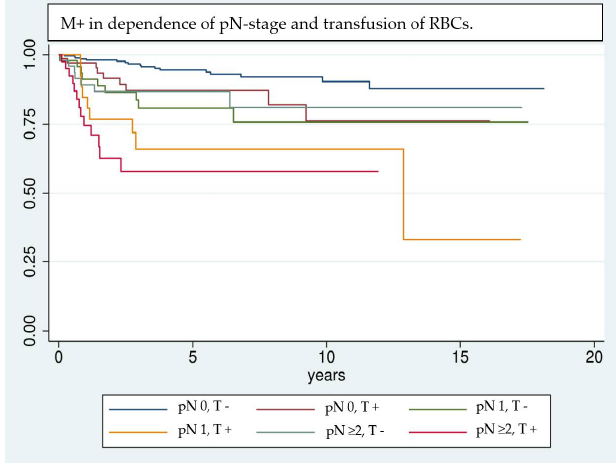
Figure 3. Comparison of patients according to their transfusion status (T +/-) and pN stage (pN 0, 1, or >= 2) using Kaplan–Meier analysis. In patients with lymph node invasion and transfusion the detrimental effects on the development of M+ are combined and lead to a remarkable worsening of the long-term outcome (pN0, T+ [red], pN1, T+ [yellow] and pN >= 2, T+ [pink]). It is notable that patients with transfusion but without lymph node invasion (red curve) show a comparable trend in the development of M+ as non-transfused patients with lymph-node invasion (light blue and green curve).